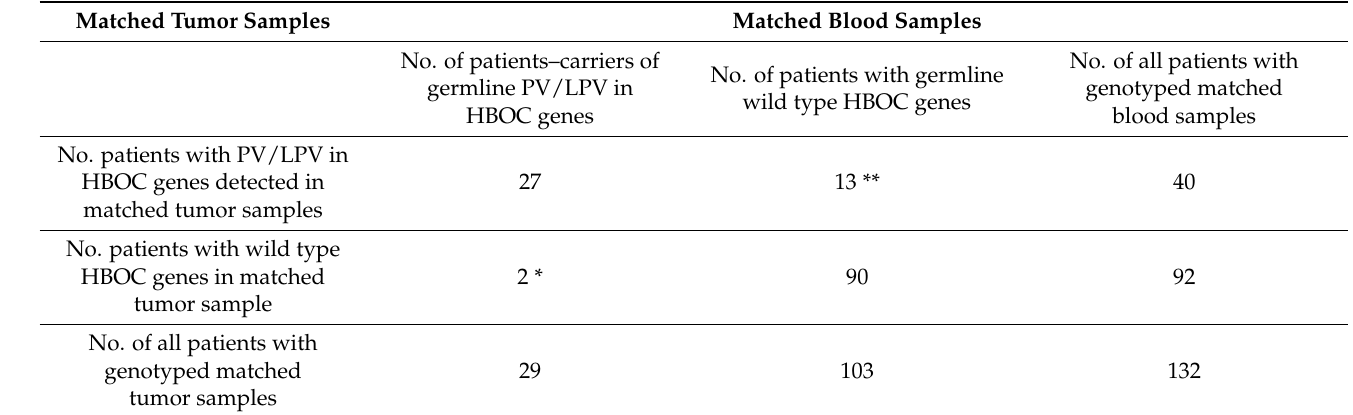
Table 5. Comparison of tumor and germline genotyping results, for germline PV/LPV in HBOC genes, of matched tumor–blood samples from the cohort of 132 advanced non-mucinous EOC patients, who had successfully genotyped tumors and blood